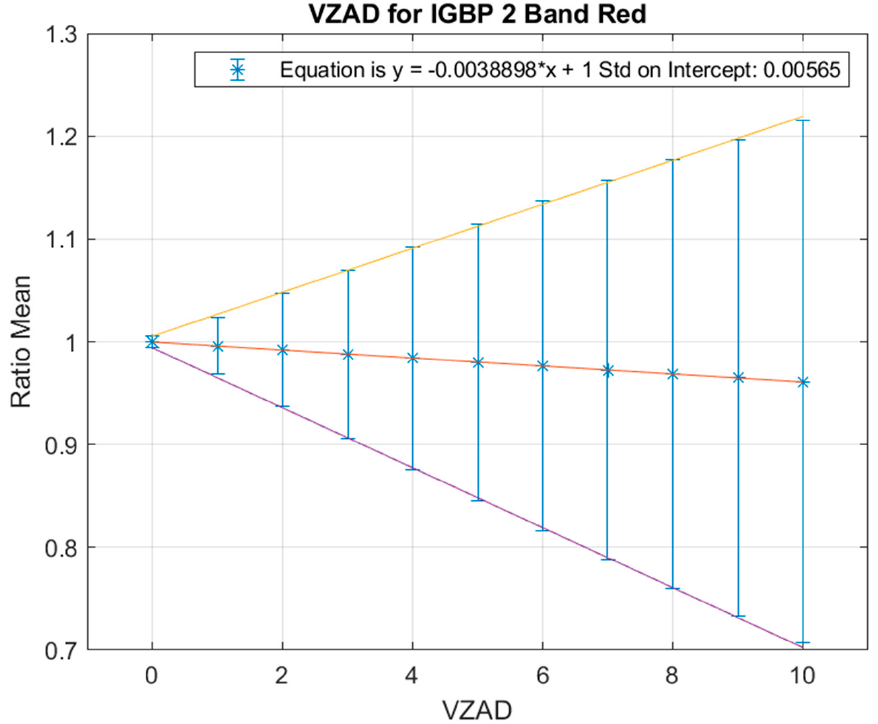
Figure 16. BRDF uncertainty at the VZAD intercept. Note that the “bowtie” effect is prominent when looking at the BRDF uncertainties while exclusively in the principal plane, which gave the worst-case scenario for uncertainty. The error bars on the VZAD intercept are the estimated BRDF uncertainty at VZAD = 0° based on the uncertainties of VZADs = 1–10°. This value was averaged with the VZAD intercept uncertainties of every IGBP type in each band to find the overall BRDF uncertainty for all the bands. Table 11. BRDF uncertainty